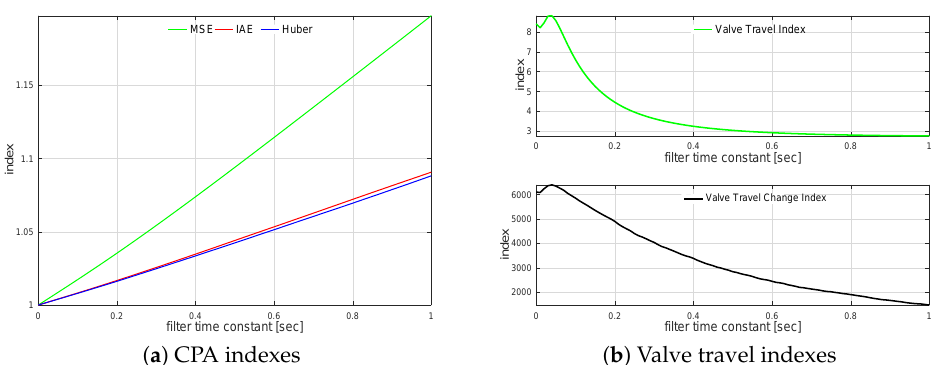
Figure 4. Process variable filtering relationships for G 2 ( s ) .